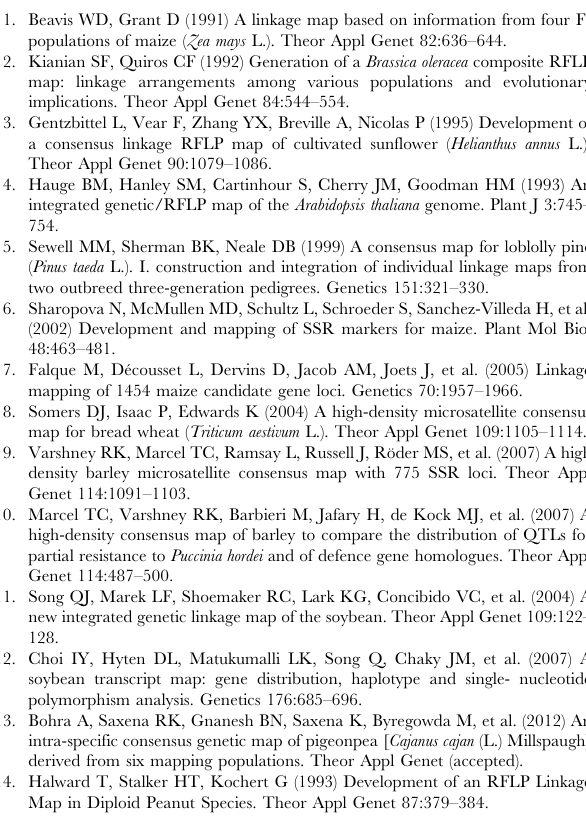
by blue hexagon, red square, pink triangle, orange circle sea green hexagon, bright square, plum triangle, blue circle, yellow hexagon, lavender square and violet triangle respectively. Figure S2 Classification of polymorphic markers into different ranges of PIC values. This figure provides frequency distribution of mapped markers with variable range of PIC values. Table S1 Details of the component and the reference consensus genetic maps with marker distances. This table provides the comparative details on mapped loci and their map distance in each LGs of component genetic maps (RIL-1, RIL-2, RIL-3, RIL-4, RIL-5, RIL-6, RIL-7, RIL-8, RIL-9, RIL- 10 and BC-1) and the reference consensus map. Table S2 Summary of consensus map based on ten RILs and one BC mapping populations. This table provides information about different homologous linkage groups used from the 11 component genetic maps for constructing the reference consensus genetic map. Table S3 Details of reference consensus genetic map with 897 marker loci based on 11 mapping populations. This table provides BIN wise information for integrated markers along with repeat motifs, PIC values and primer sequence information.